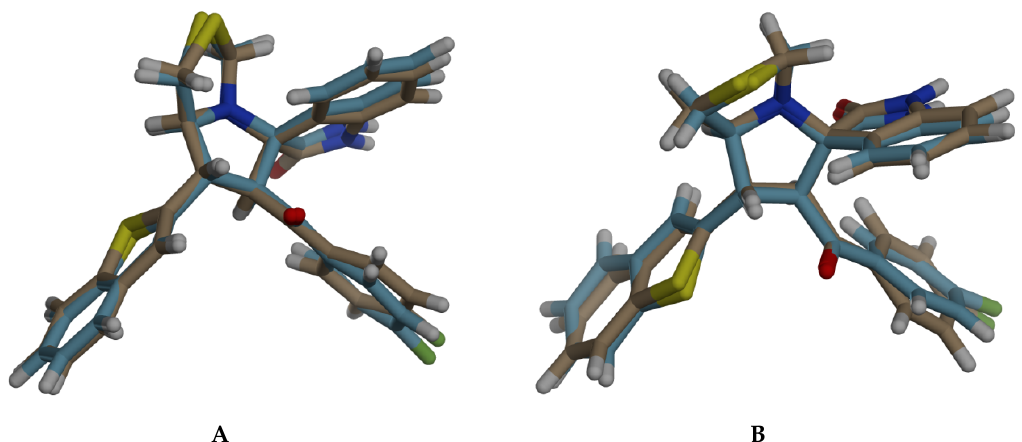
Figure 8. Structure matches of the optimized and calculated structures for conformers A ( left ), and B ( right ).